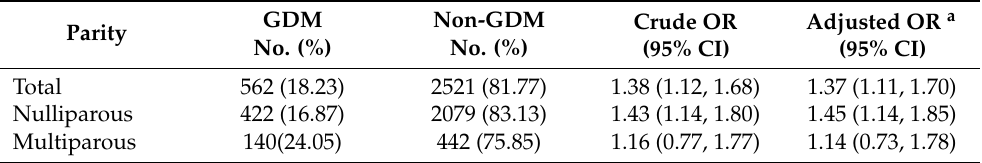
Table 3. Association between passive smoking and GDM stratified by